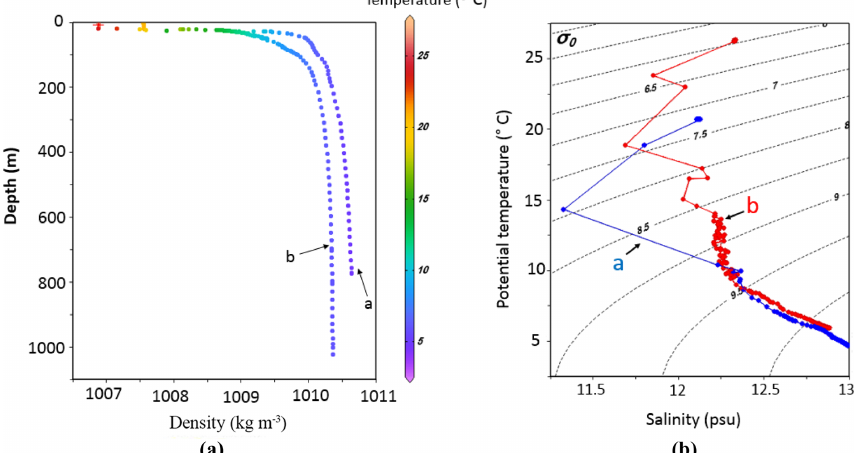
Figure 2. (a) Comparison of density between stations a and b (middle and southern basins, see Fig. 1b) indicating the difference in density ( ∼ 0 . 5kgm − 3 ) between the two basins. (b) A T – S diagram for stations a and b to show differences in temperature and salinity, particularly in deep water. To plot this diagram, the potential temperature and potential density anomaly ( σ 0 ) are calculated from the CTD data. The T – S diagram confirms the differences in density in deep water for σ 0 > 10kgm − 3